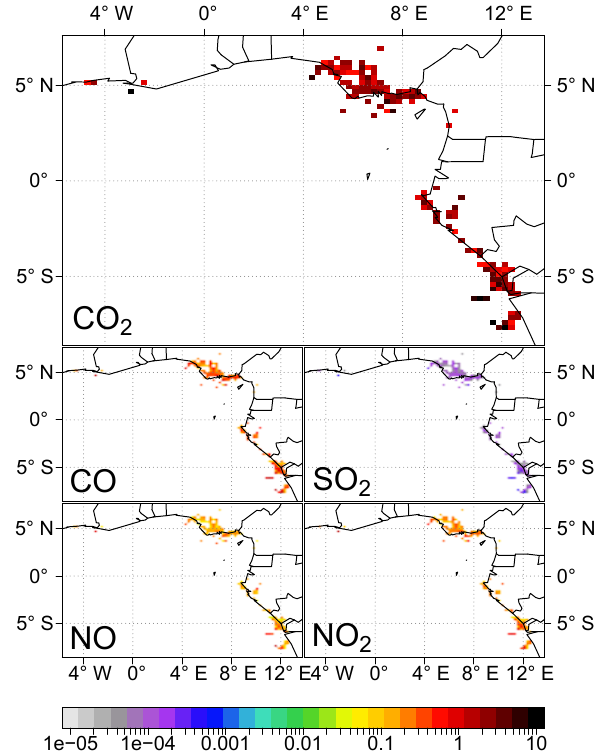
Figure 3. Flaring emissions for TP15 within E clim in th − 1 consid- ering CO 2 , CO, SO 2 , NO and NO 2 . For better visibility the emis- sions are displayed as colored grid boxes although the emissions are still point sources and not area